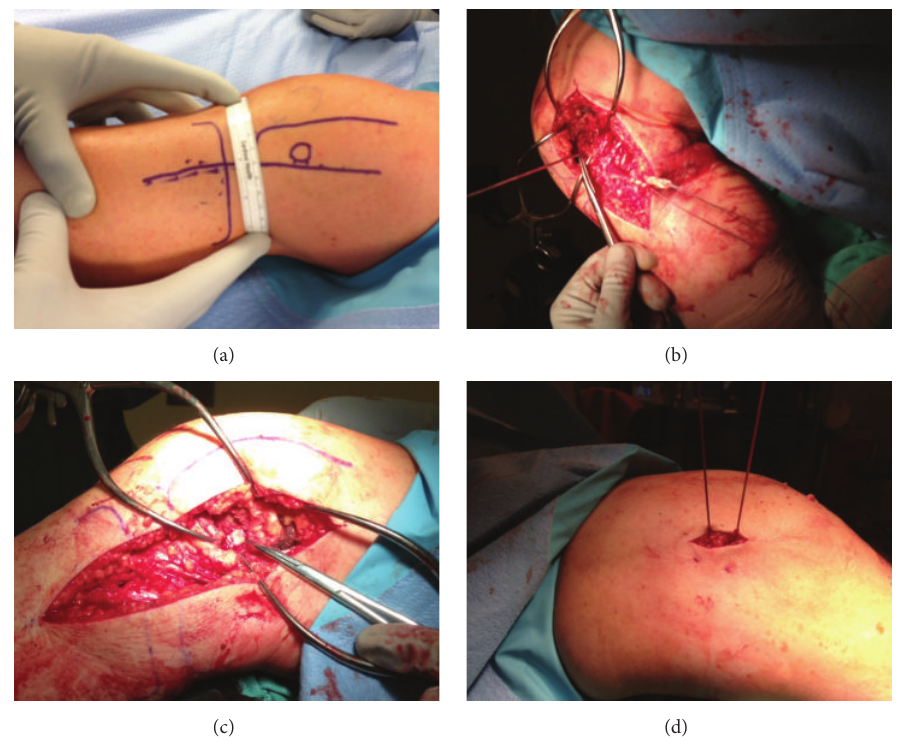
Figure 1: Intraoperative pictures demonstrating the surgical technique. (a) Minimum 7 cm distance between the anterior skin incision (from previous surgical procedures) and the new incision for the posterolateral corner injury. (b) The tibialis anterior allograft has been passed through the proximal fibula, and a Beath pin has been placed in the desired location for the femoral attachment (pointed by the Metzenbaum scissors). (c) Final appearance of the allograft fixed with the screw in the lateral aspect of the distal femur. (d) Medial view of the knee demonstrating the passage of the 2 Beath pins through the femoral socket to create two independent tunnels. The pins are used to pass a suture in each one to create the additional aperture fixation in the medial